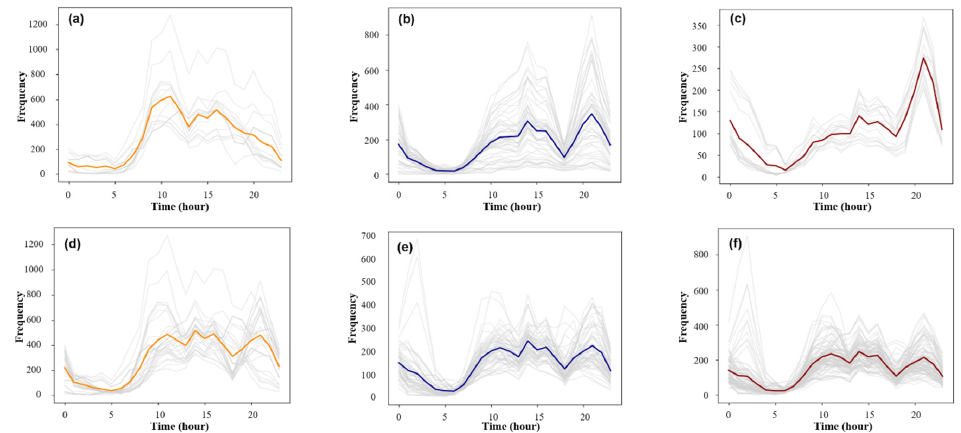
Figure 7. Clustering results of the simulation experiments: ( a – c ) the clustering results of the proposed method and ( d–f ) the clustering results of the K-means